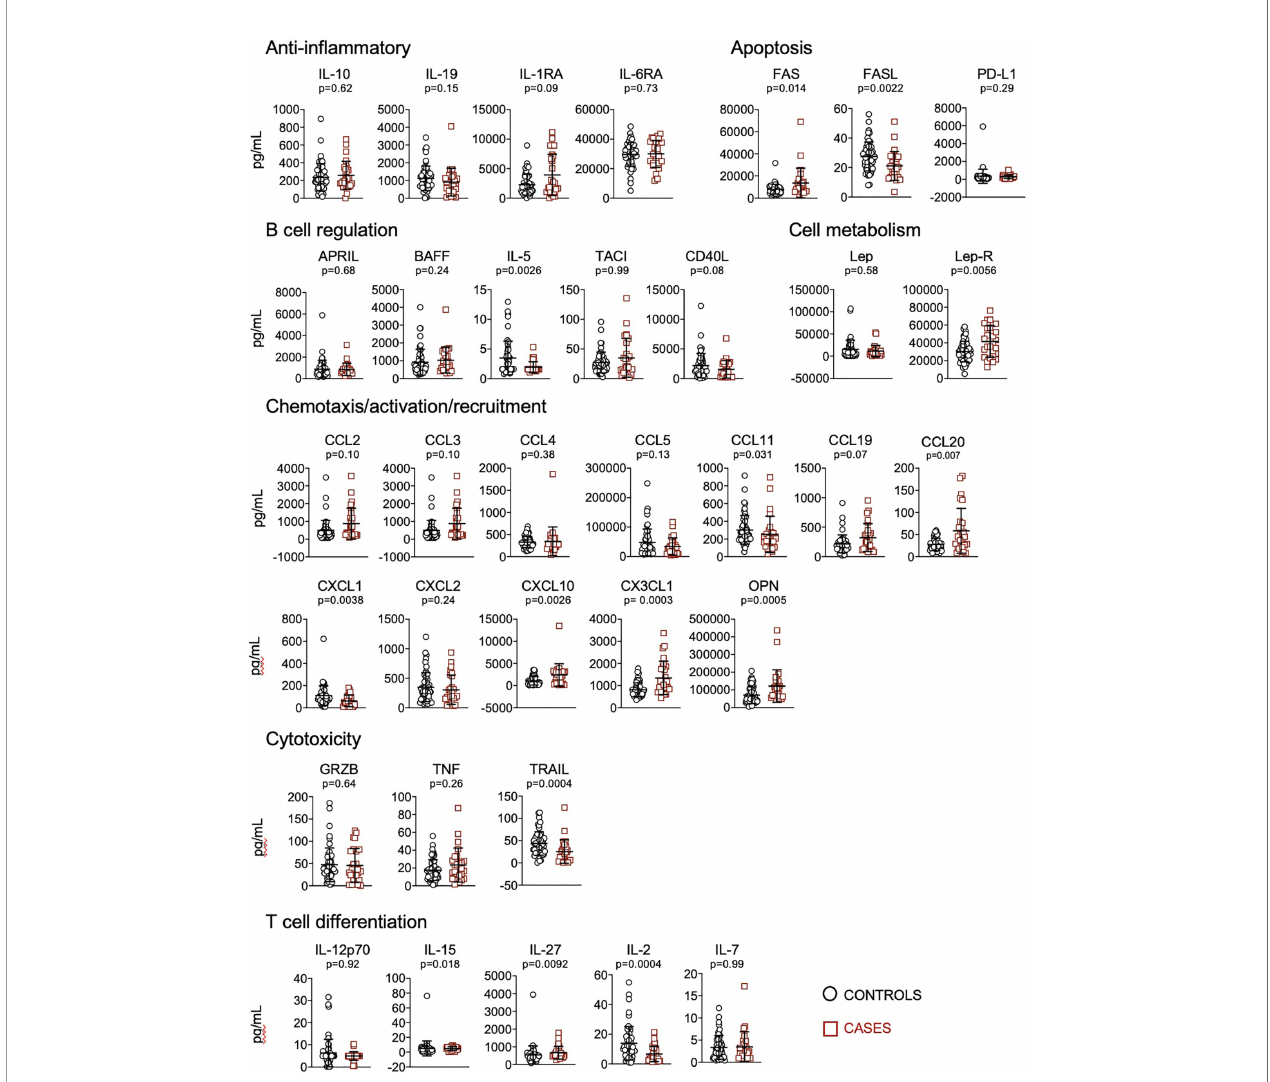
FIGURE 1 | Quanti fi cation of cytokines and other biomarkers involved in anti-in fl ammatory responses, apoptosis, B cell regulation, cell metabolism, chemotaxis/ activation/recruitment, cytotoxicity and T cell differentiation, in plasma obtained from controls (n=57) and cases (n=23). Data represent mean and standard deviation of the mean. Mann-Whitney test was used for statistical